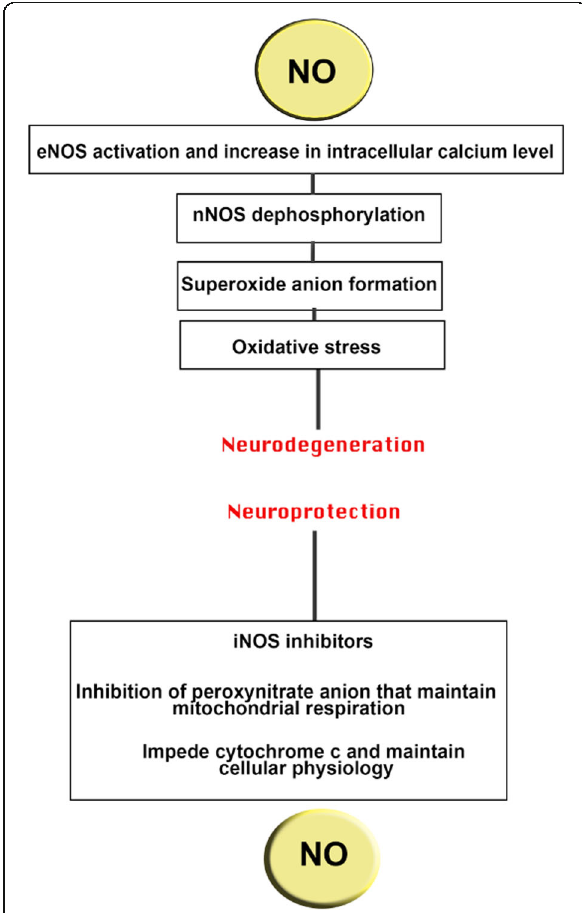
Fig. 1 Neuroprotective and neurodegenerative aspects of NO. By activating eNOS (endothelial NO synthase), NO causes neurodegeneration which increases intracellular calcium (Ca 2+ ) level following nNOS